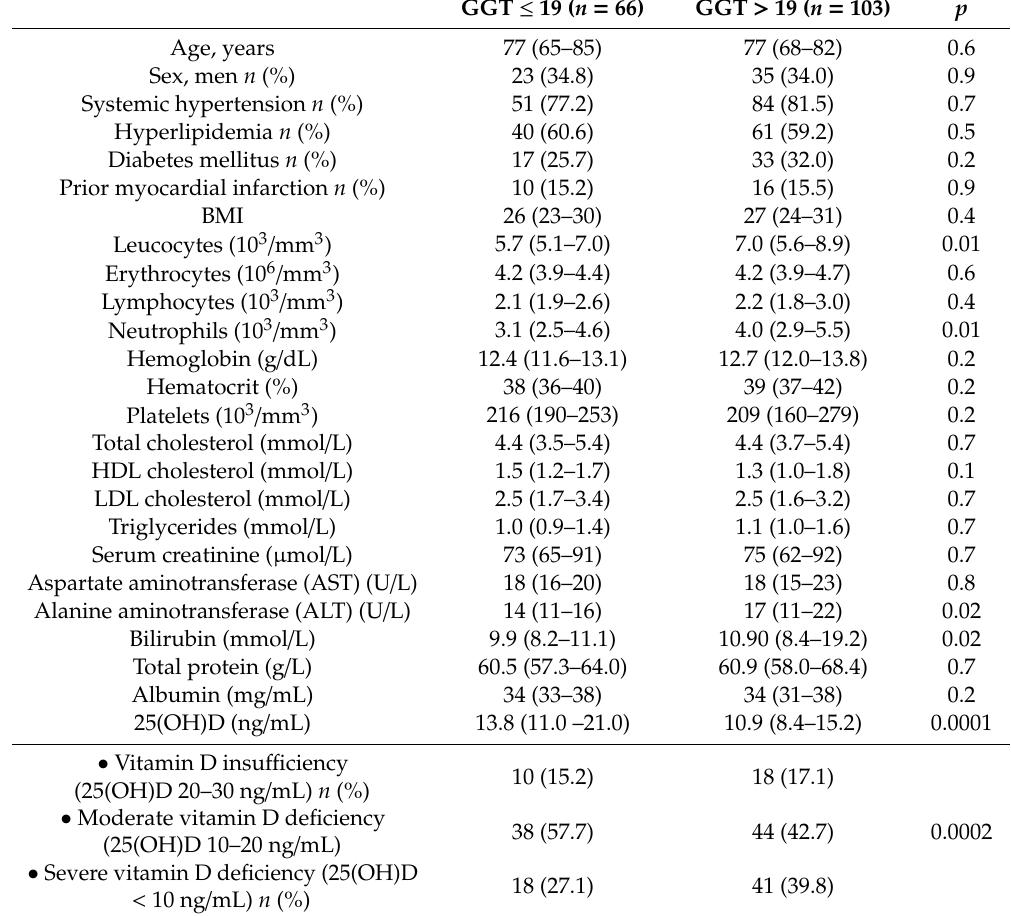
Table 5. Clinical and laboratory features based on GGT status. Values are presented as medians (interquartile range) or n